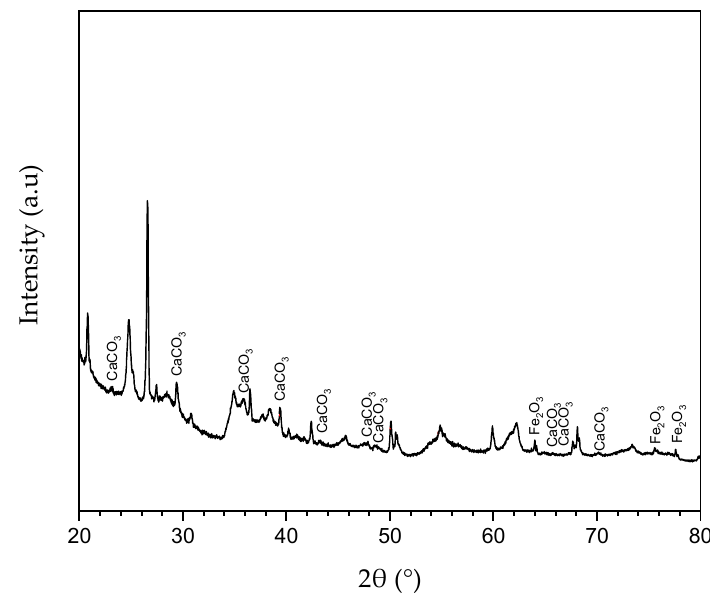
Figure 11. X-ray di ff raction for Indiana limestone Figure 11. X-ray diffraction for Indiana limestone sample.